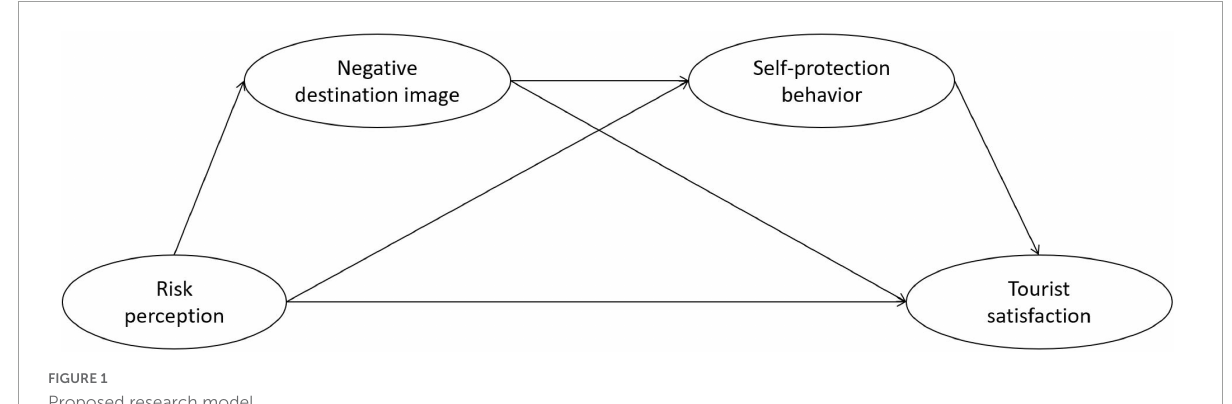
FIGURE1 Proposed research